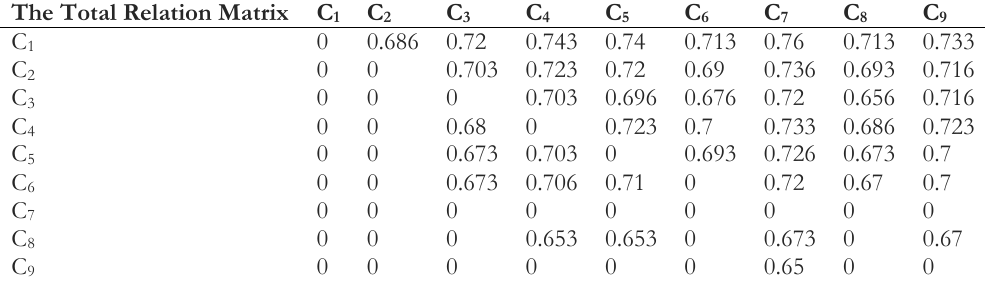
Table 8. The interrelationships between the factors.